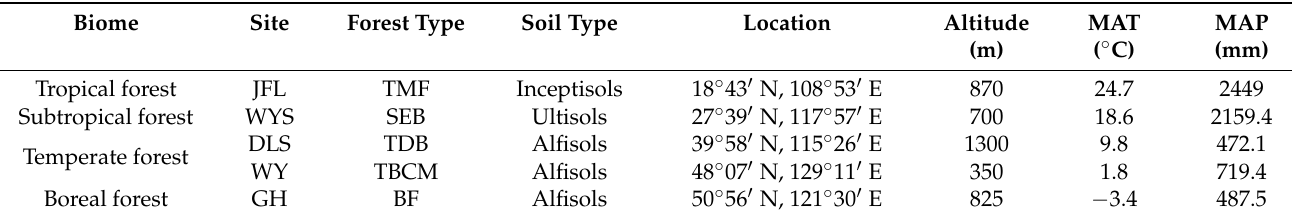
Table 1. General information on the NEECF